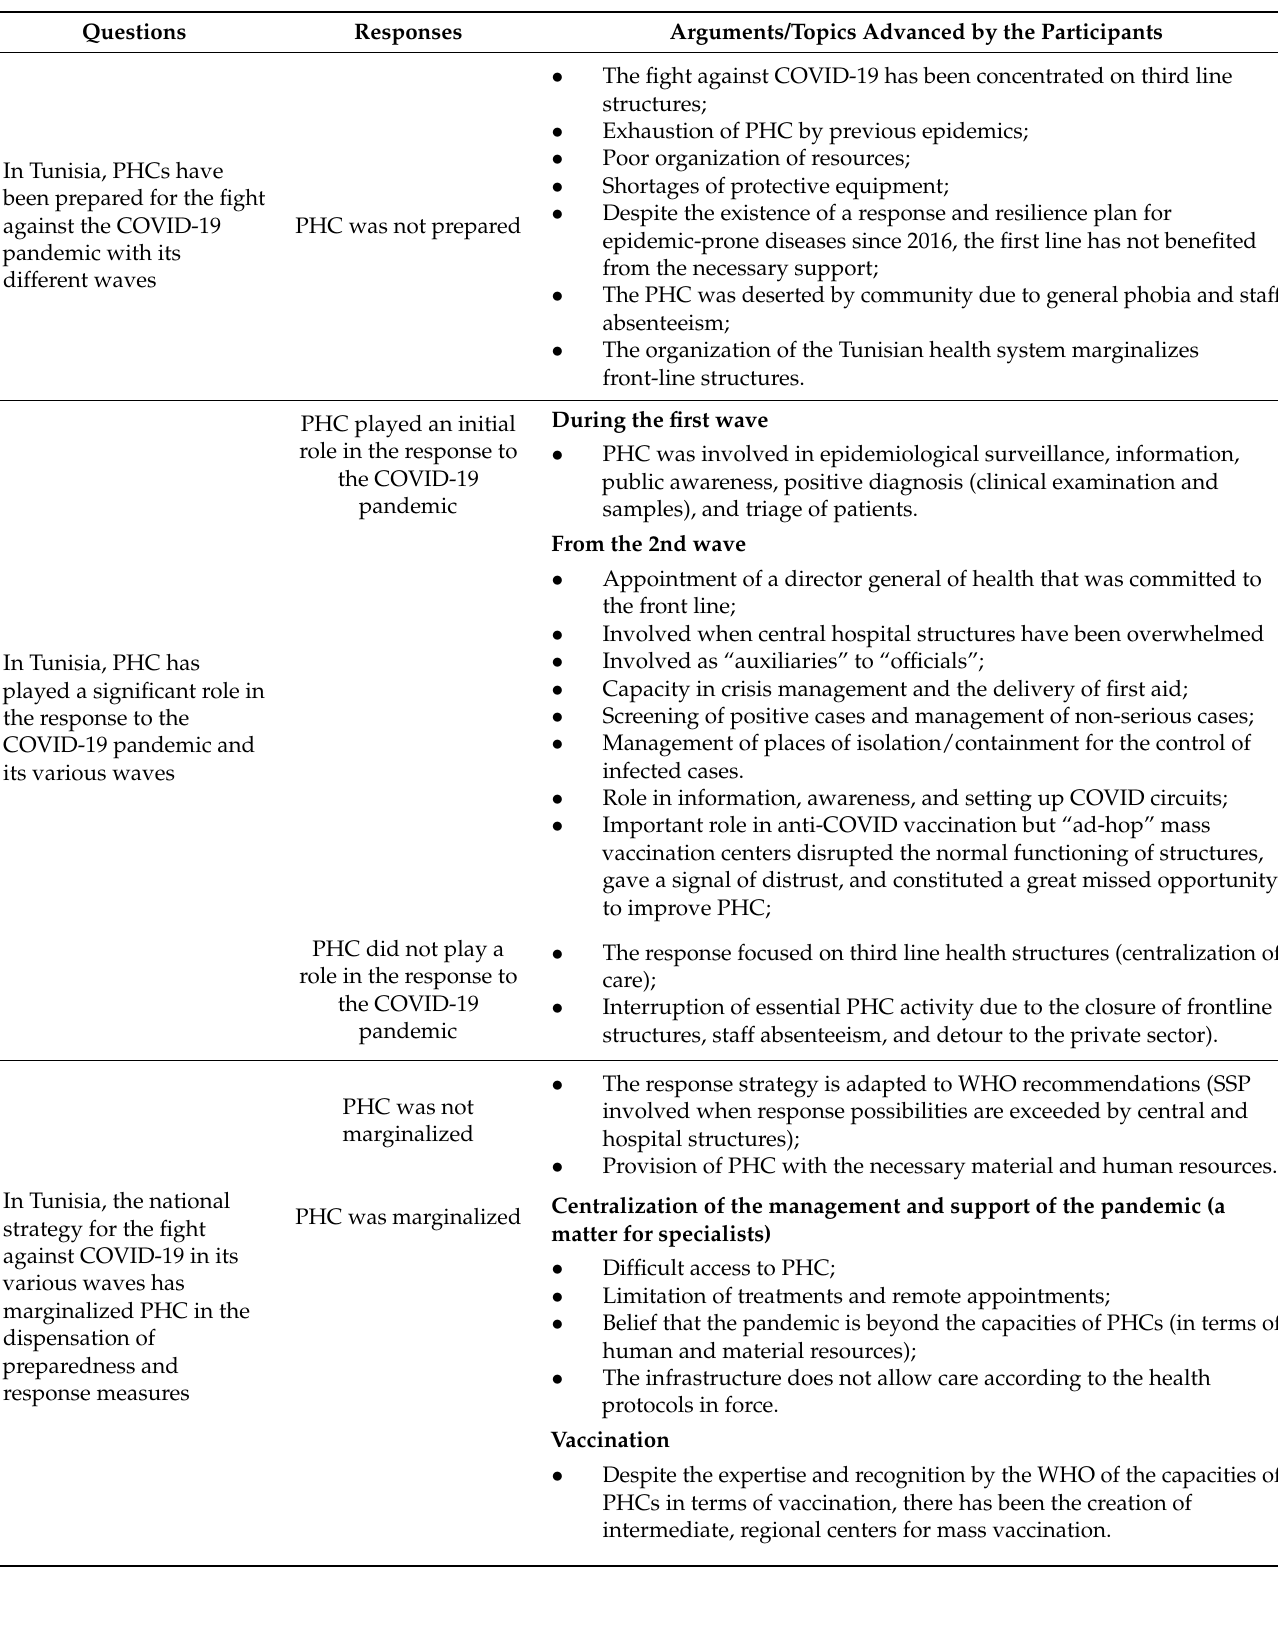
Table 2. Different responses and arguments to the five themes of the study according to the 25 partic- ipants of the study whodescribed the role of the Tunisian Primary Health Care in the management of the COVID-19